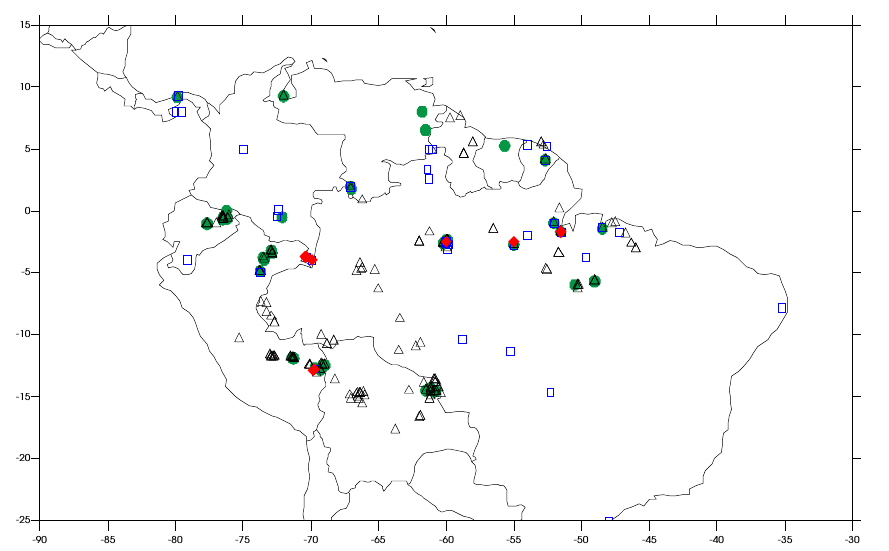
Fig. 1. Locations of ground observations. Black triangles: above ground woody biomass (Malhi et al., 2006). Green dots: above ground woody NPP (Malhi et al., 2004). Red diamonds: allocation fractions (Arag˜ao et al., 2009). Blue squares: leaf and fruit allocation (Chave et al.,